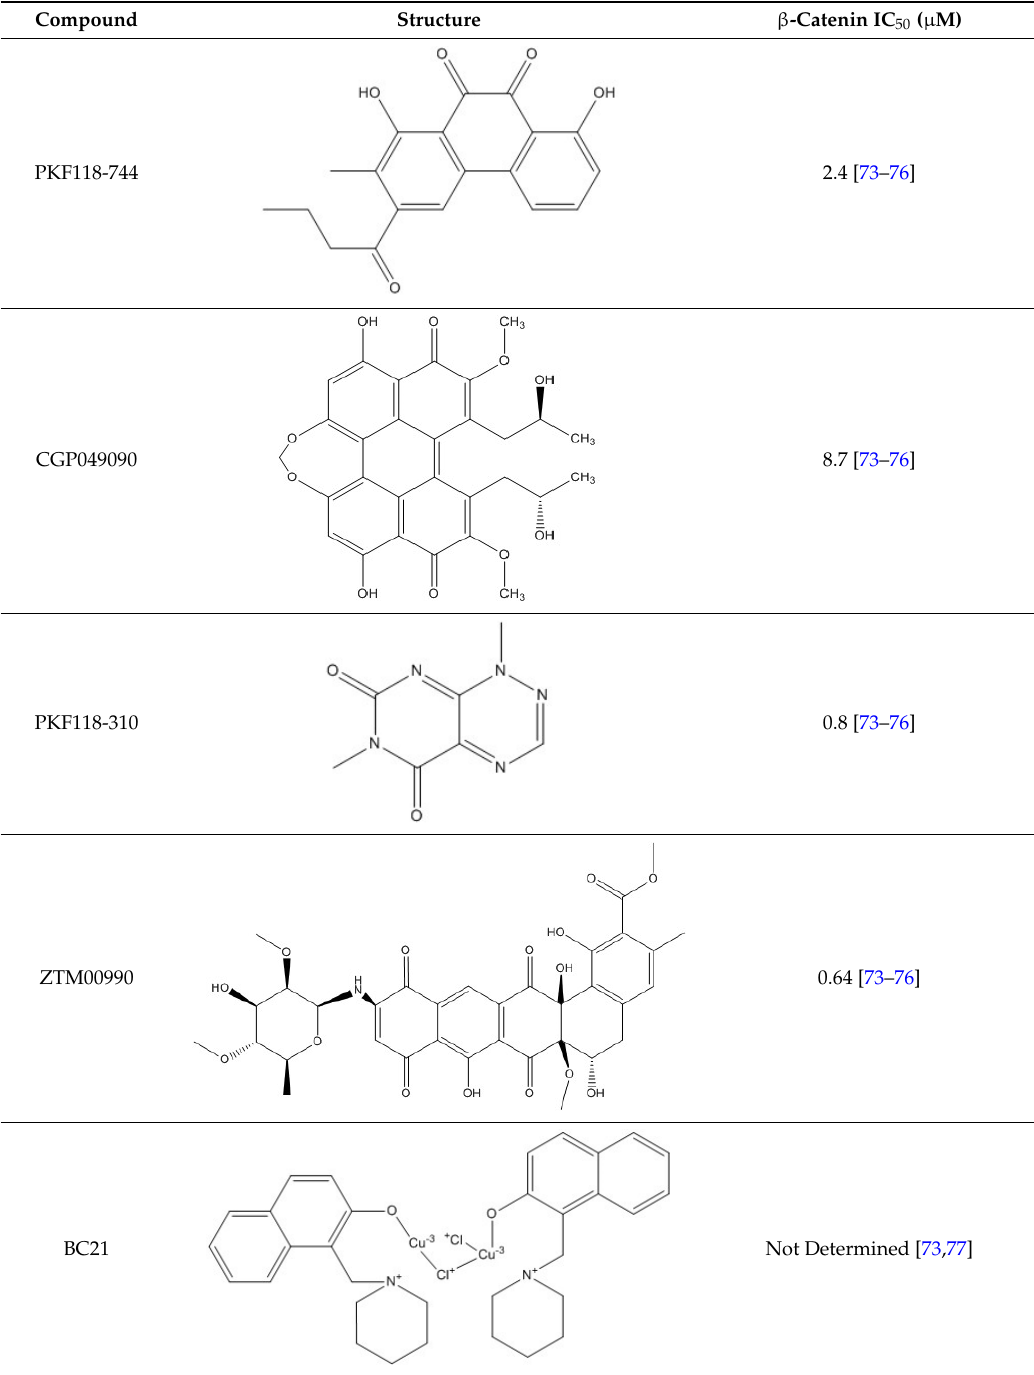
Table 4. Structures and activities of polyphenol inhibitors against β -catenin/Tcf.